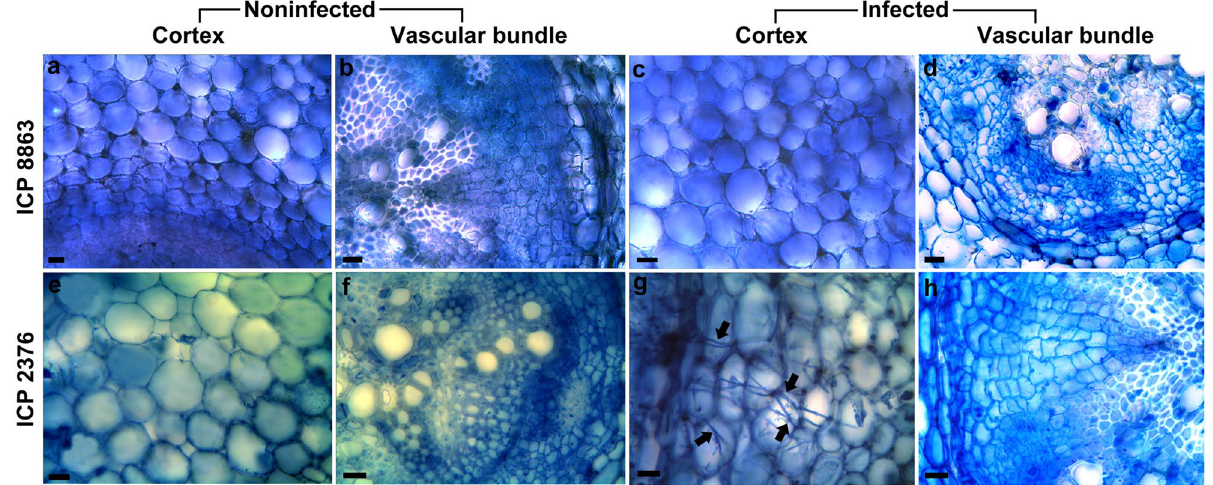
Figure 1. Transverse sections of control and Fusarium udum isolate M1 inoculated roots of pigeonpea at 36 h post inoculation. ( a , b ) Non-inoculated control roots of resistant ICP 8863 cultivar, ( c , d ) roots of ICP